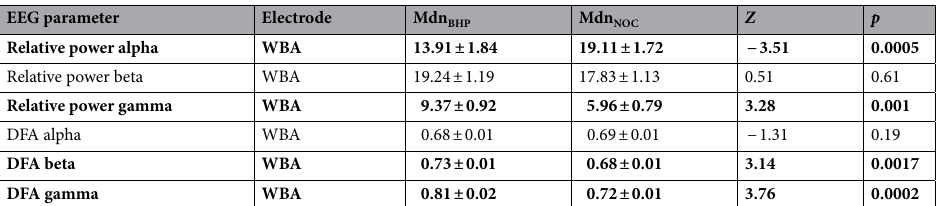
Table 2. Summary of statistics for differences in EEG parameters between nocebo during evocation and baseline high pain shown in Fig. 4. Wilcoxon signed-rank tests were performed on the whole-brain average per subject (computed as mean of all electrodes). Rows show EEG parameters, columns show the median whole-brain average value across subjects for control and nocebo trials, Z - and P -value corresponding to the signed-rank test. The median EEG parameter value for each group is reported with the standard error of the mean. BHP Baseline high pain, NOC Nocebo trials during evocation. Bold font weight indicates significance at P <